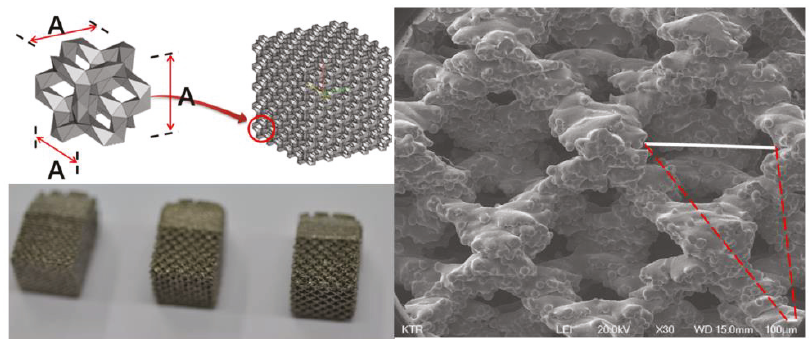
Figure 1. The 3D printing porosity size samples for SEM.